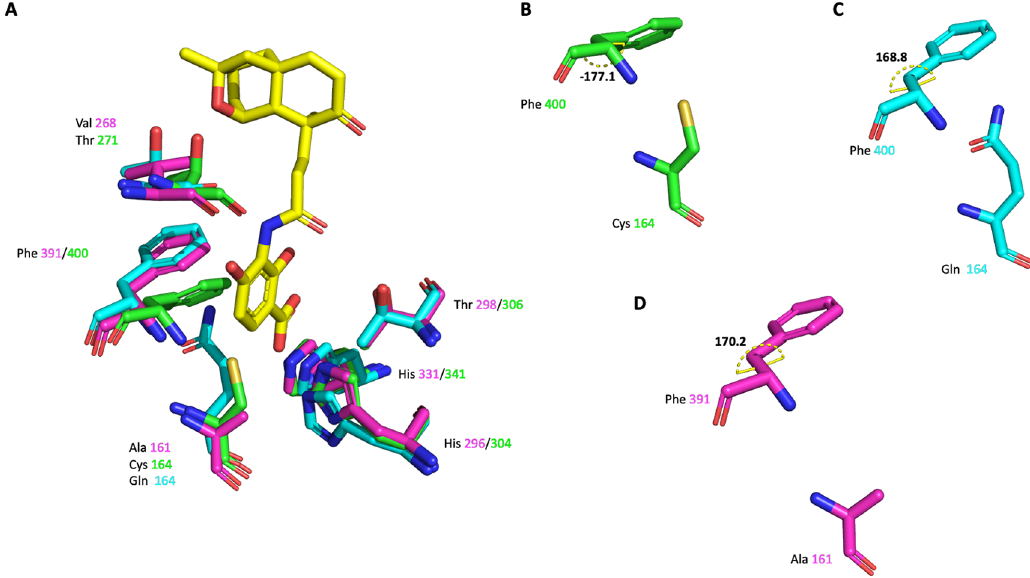
Figure 8. Alignment of the malonyl binding site of Pa FabF (PDB Id 4JPF), Pa FabF C164Q (7OC1) and Pa FabB C161A(7PPS). A)Theactivesiteresiduesofthethreedifferentenzymesareshownassticks.Platensimycinbindingto Pa FabF C164Q is shown as yellow sticks. Side chain conformation and dihedral angle C-CA-CB-CG of Phe391/400 is shown in B) for Pa FabF C) for Pa FabF C164Q and D) for Pa FabB C161A.